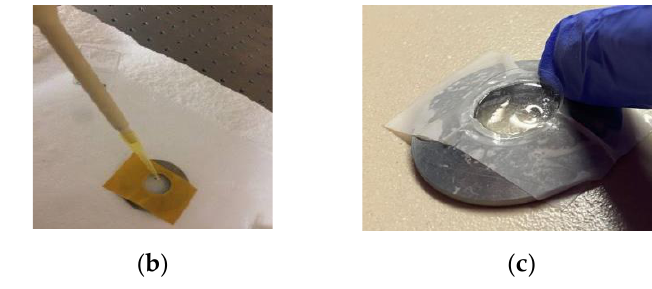
Figure 1. An illustration of an exosome sample process prepared for MPTflex microscope analysis: photographs of a glass plate with adhesive tape ( a ), the process of the exosome sample’s positioning on the glass plate ( b ), and this construction being covered from above with another glass plate ( c ). For each sample, FLIM images from depths of about 3–4 µ m with sizes of 18 × 18 µ m, 52 × 52 µ m, and 118 × 118 µ m were recorded in five randomly selected spatial